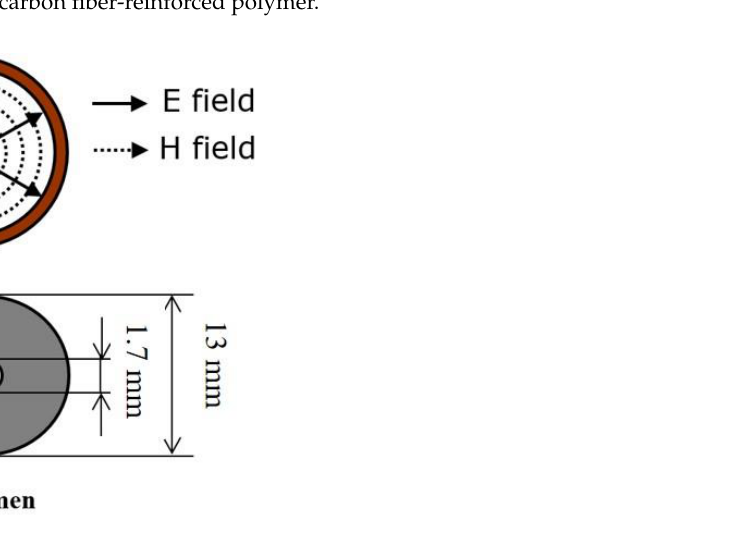
Figure 2. Distribution of the electric field inside the coaxial tube and the specimen dimension used for coaxial transmission line measurement.